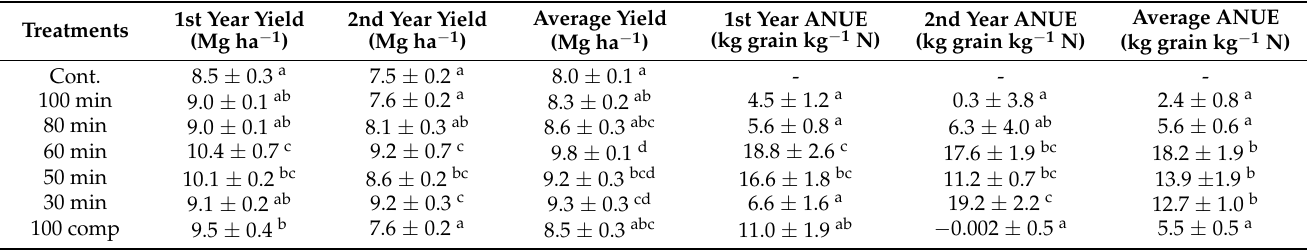
Means followed by the different lower-case letters within a column indicate significant differences among the treatments (Tukey HSD test, p < 0.05). Cont.: Control (no input); 100 min: 100% mineral fertilizer N (100 kg N ha − 1 ) and P (33.3 kg P ha − 1 ), 80 min: 80%